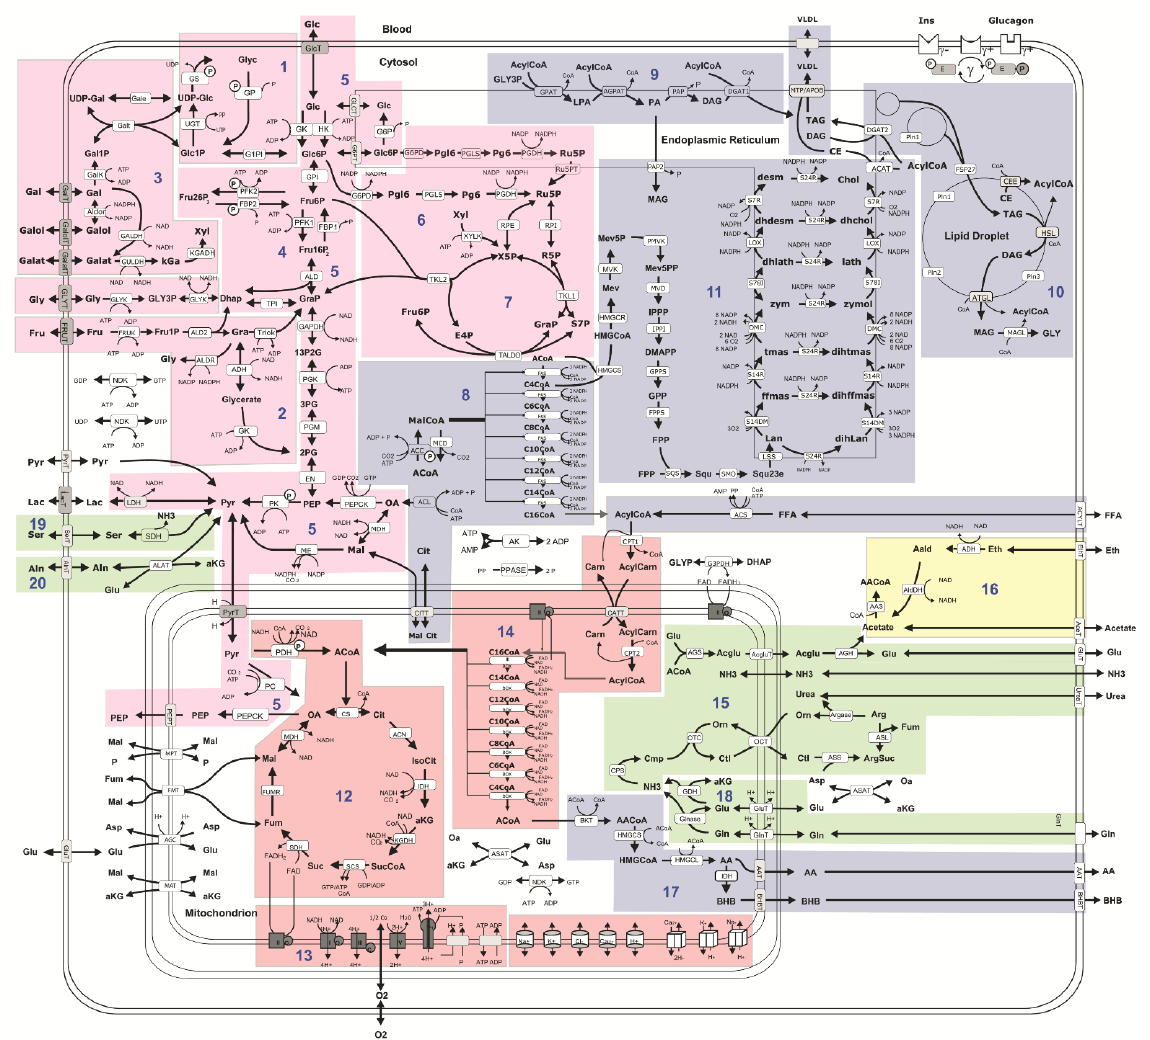
Figure 8. Schematic model representation. Reactions and transport processes between compartments are symbolized by arrows. Single pathways as defined in biochemical textbooks are numbered and highlighted by different coloring: ( 1 ) glycogen metabolism, ( 2 ) fructose metabolism, ( 3 ) galactose metabolism, ( 4 ) glycolysis, ( 5 ) gluconeogenesis, ( 6 ) oxidative pentose phosphate pathway, ( 7 ) non-oxidative pentose phosphate pathway, ( 8 ) fatty acid synthesis, ( 9 ) triglyceride synthesis, ( 10 ) synthesis and degradation of lipid droplets and synthesis of VLDL lipoprotein, ( 11 ) cholesterol synthesis, ( 12 ) tricarbonic acid cycle, ( 13 ) respiratory chain and oxidative phosphorylation, ( 14 ) β -oxidation of fatty acids, ( 15 ) urea cycle, ( 16 ) ethanol metabolism, ( 17 ) ketone body synthesis, ( 18 ) glutamine metabolism, ( 19 ) serine utilization, and ( 20 ) alanine utilization. Lipid droplet synthesis and degradation pathways include de novo synthesis of lipid droplets, lipid droplet filling, lipid droplet growth and fusion as well as lipid droplet degradation in dependence on regulatory surface proteins [15]. Small cylinders and cubes symbolize ion channels and ion transporters. Double arrows indicate reversible reactions, which may proceed in both directions according to the value of the thermodynamic equilibrium constant and cellular concentrations of their reactants. Reactions are labeled by the short names of the catalyzing enzyme or membrane transporter given in the small boxes attached to the reactions arrow. Red boxes indicate enzymes that are regulated by hormone-dependent reversible phosphorylation. Metabolites are denoted by their short names. Full names of metabolites and kinetic rate laws of reaction rates are outlined in Berndt et al. [14] and Wallstab et al. [15]. The figure was adapted from Figure 1 of reference [14] by updating and rearranging pathways ( 9 )–( 11 )